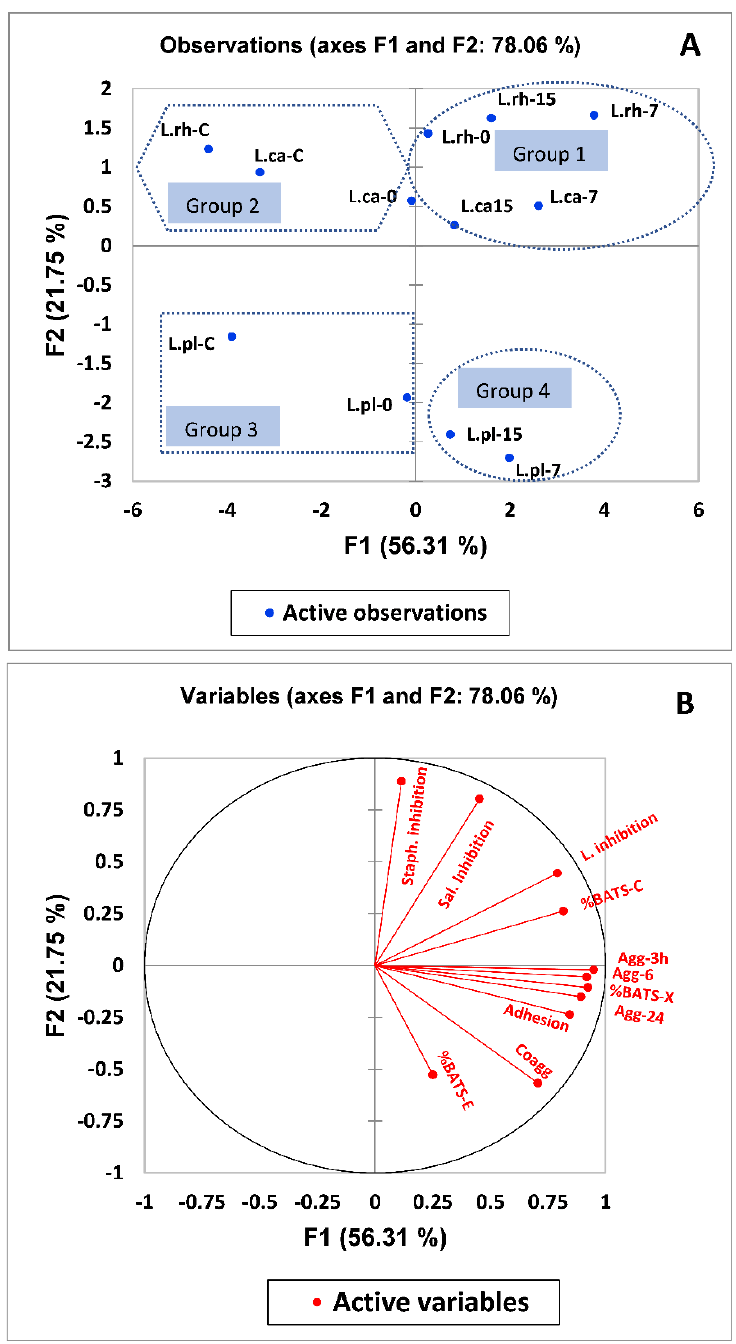
Figure 6. ( A ) Principal component (PC) analysis biplot of physicochemical cell surface